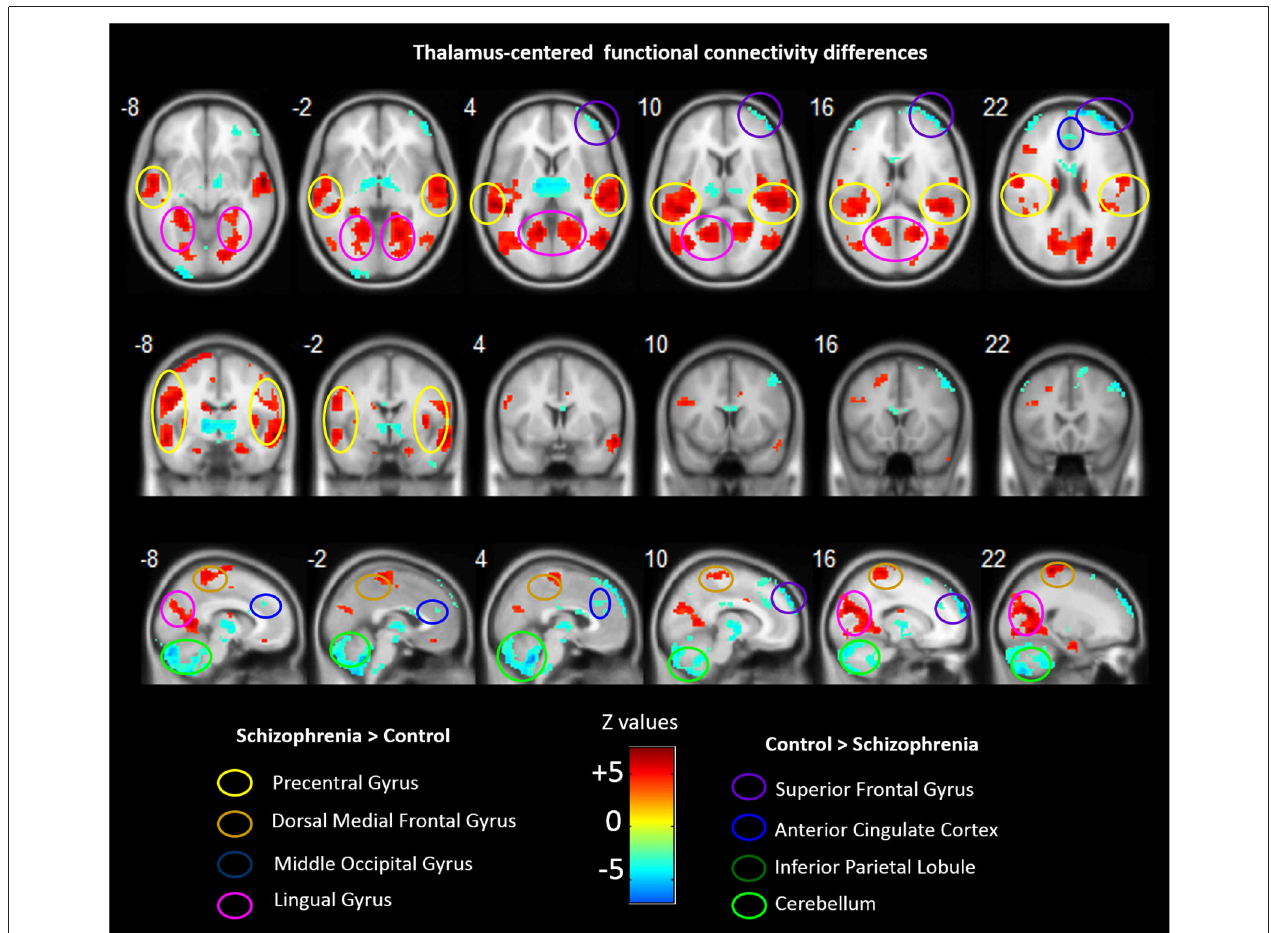
FIGURE 2 | Abnormal FC associated with the thalamus in schizophrenia . Hot color represents higher FC with thalamus in schizophrenia, whereas blue cold color represents lower FC in schizophrenia. Images are in radiologic format with subject left on image